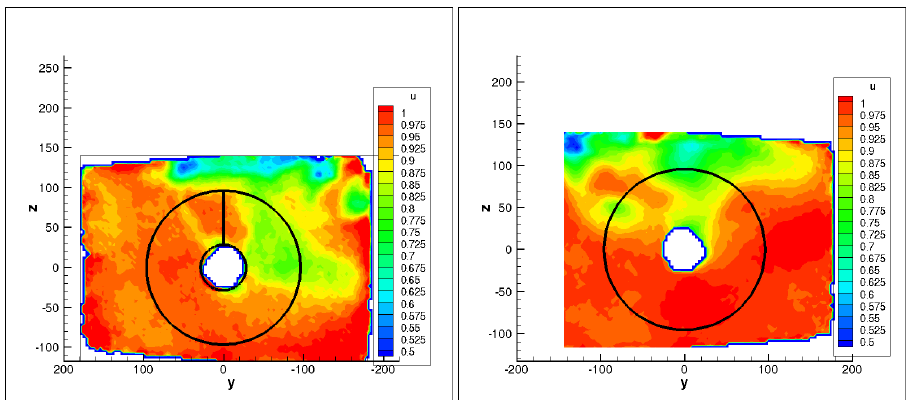
Figure 8. Nominal wake of the model hull without rudders in steady drift motion: Stereo-PIV measurements of the axial velocity component on the transverse plane close to the propeller shaft end. ( Left ): portside. ( Right ): starboard.